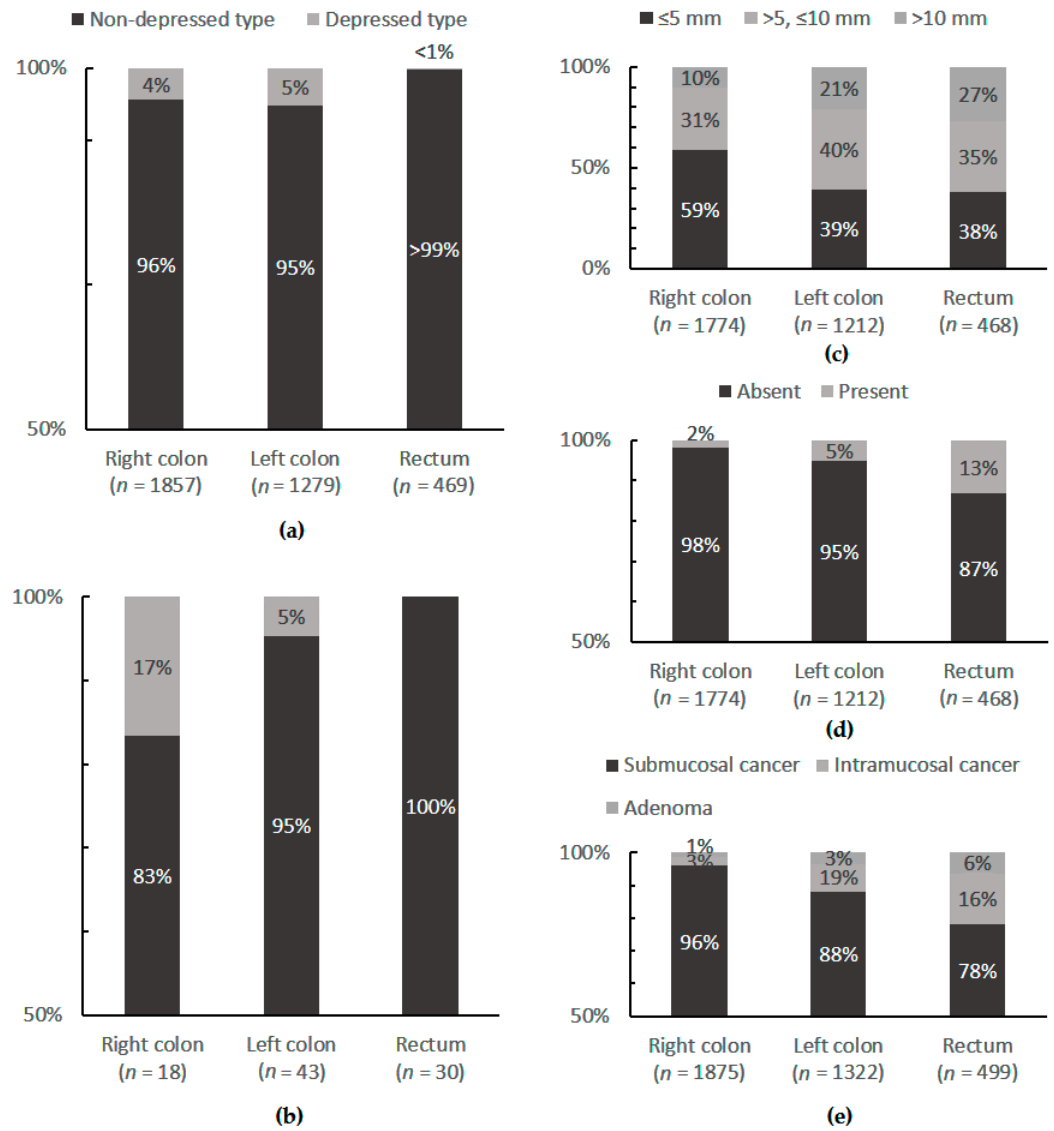
Figure 1. Comparison of the incidences of depressed and non-depressed types of neoplastic lesions in the rectum, the left colon, and the right colon. ( a ) Mucosal lesions; ( b ) submucosal cancers. A significant difference in the macroscopic type was noted between the rectum and the colon ( p < 0.001). The incidence of depressed submucosal cancers in the right colon was significantly higher than that in the rectum ( p = 0.0472); ( c ) Relationship between the location and the size of non-depressed mucosal lesions; ( d ) Relationship between the location and the incidence of villous components in non-depressed mucosal lesions; ( e ) Locations of mucosal lesions and submucosal cancers. (Adapted from Konishi et al. 1999 [28].)